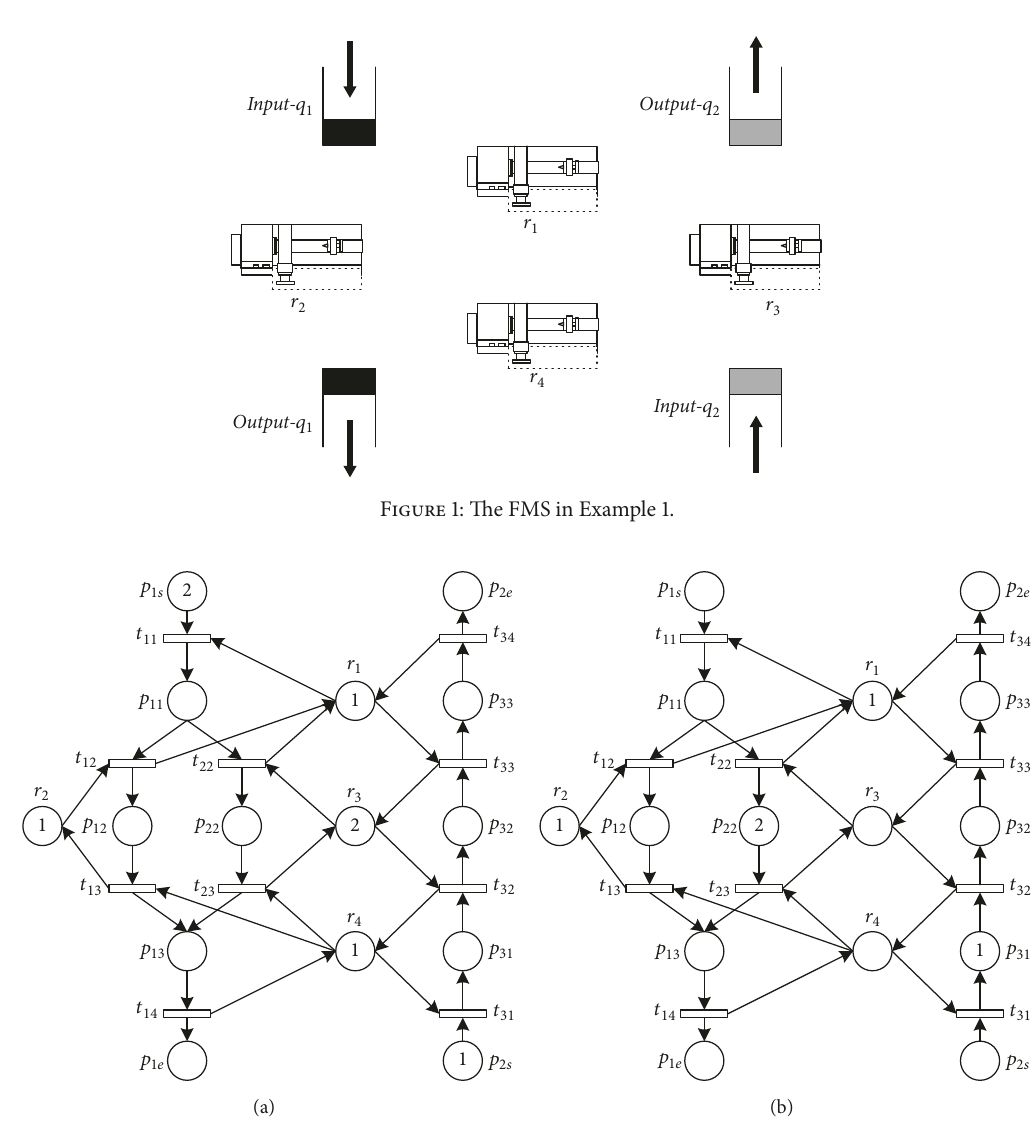
Figure 2: (a) The PNS of an FMS and (b) its deadlock